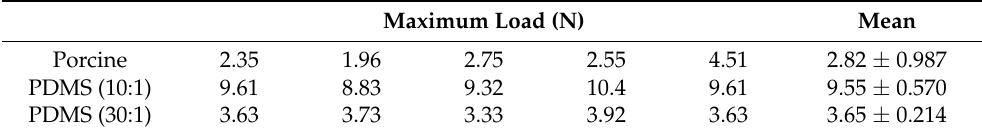
Table 1. The pull-out strength tested by different specimens.